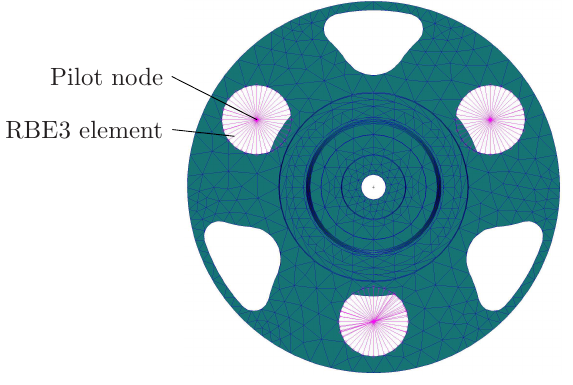
Figure 13: Pilot nodes on